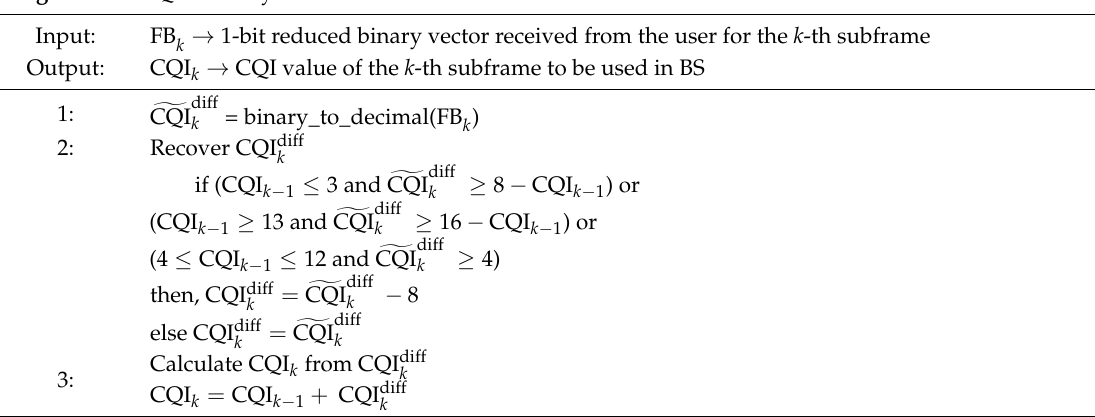
Algorithm 4 CQI recovery at BS from 1-bit reduced feedback